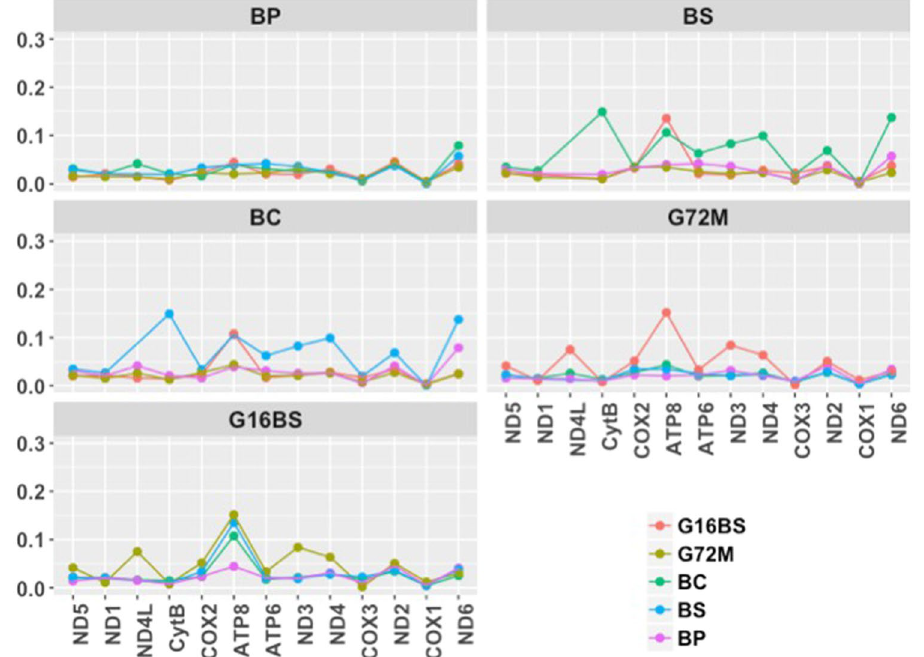
Figure 4. Heat-maps showing the Ka/Ks ratios for pairwise comparison of all 13